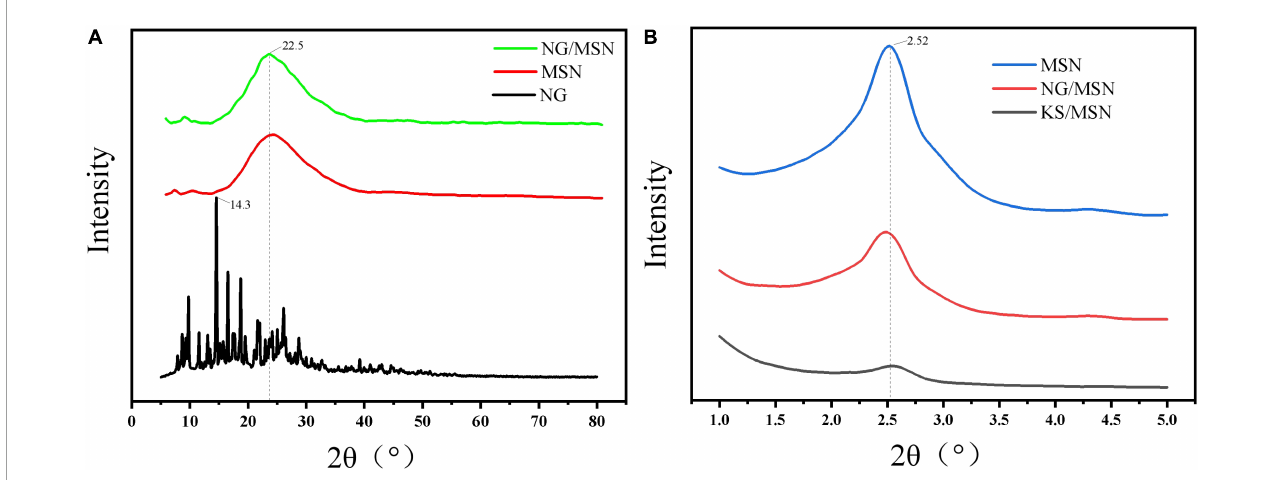
FIGURE3 X-ray diffraction analysis (XRD) images of NG, MSN, and NG/MSN in wide-angle mode (A) and MSN, NG/MSN, and KS/MSN in small-angle mode (B) .